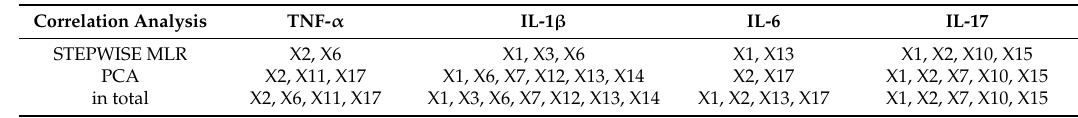
Table 8. Integration of the analytical results.